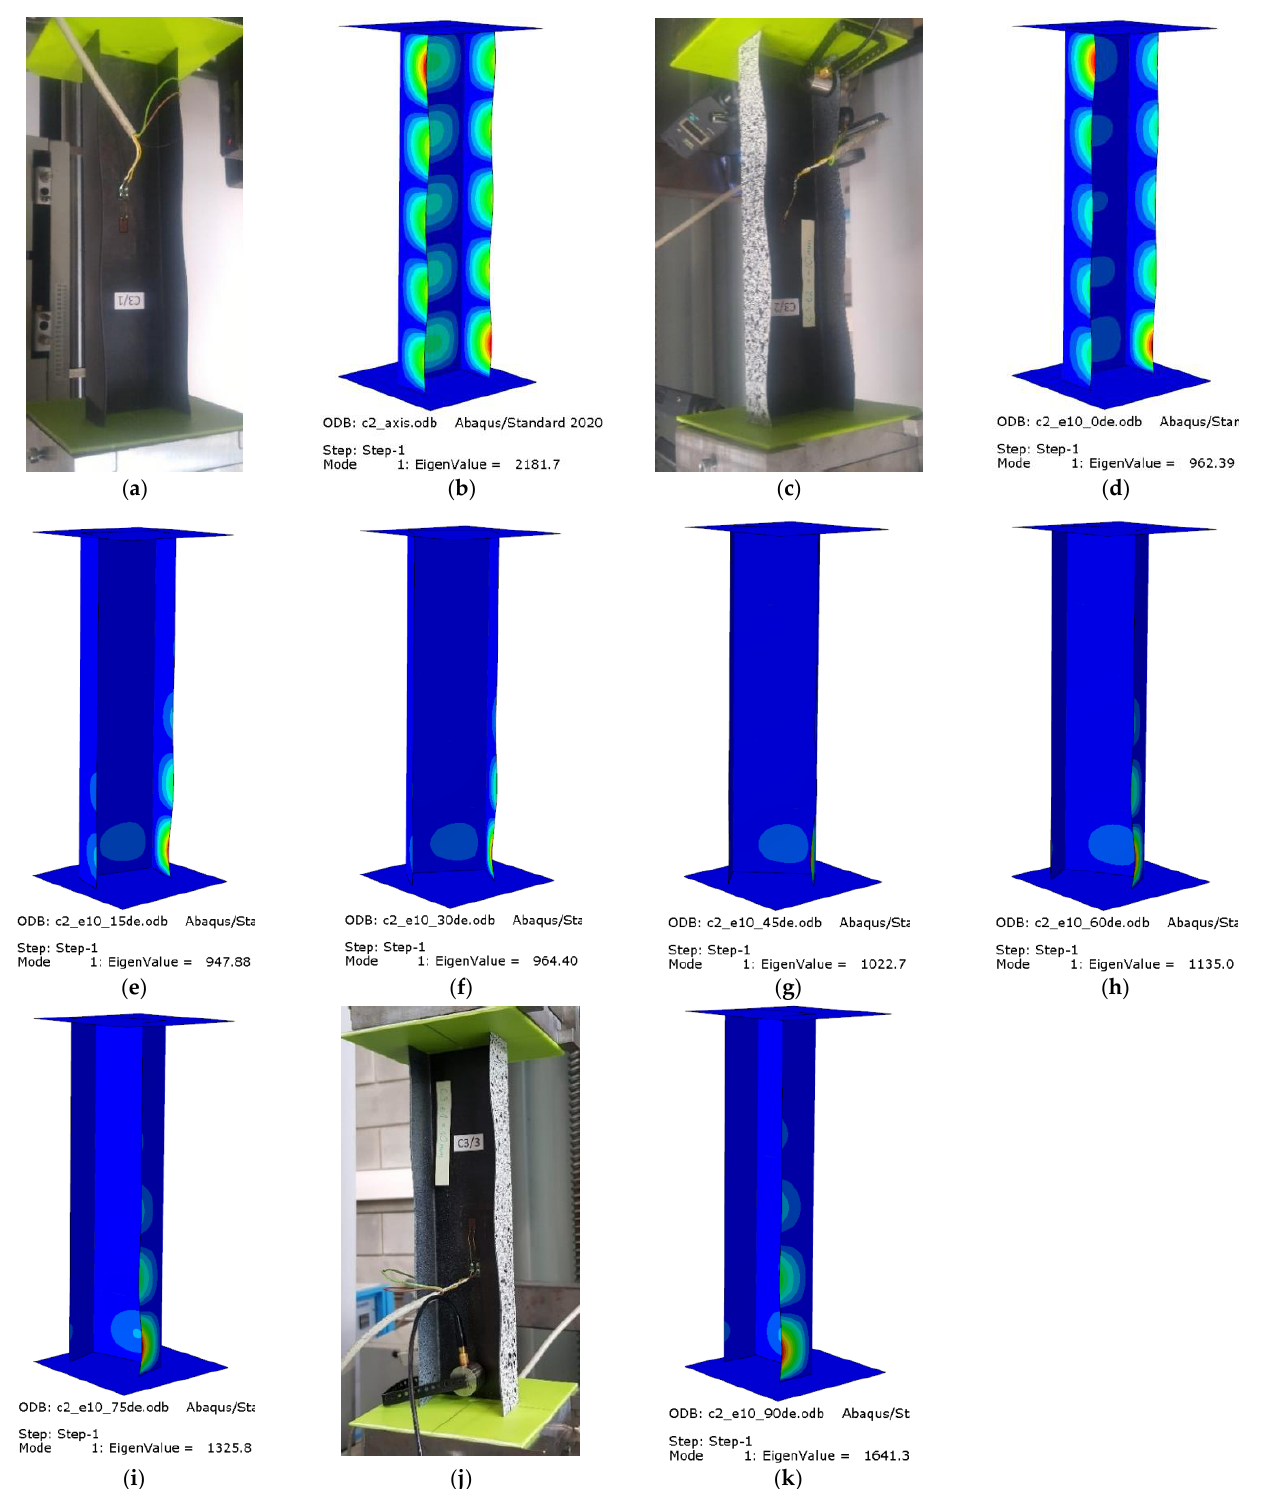
Figure 9. Buckling modes for C2 [90/ − 45/45/0] s : ( a ) axis EXP, ( b ) axis FEM, ( c ) e10_0° EXP, ( d ) e10_0° FEM, ( e ) e10_15° FEM, ( f ) e10_30° FEM, ( g ) e10_45° FEM, ( h ) e10_60° FEM, ( i ) e10_75° FEM, ( j ) e10_90° EXP, ( k ) e10_90° FEM. For the axially compressed column C1 (Figure 8a,b), local buckling of the web and walls occurs, having the form of two longitudinal half-waves symmetric to the longitudinal symmetry plane of the column. There is no change in the buckling mode of the C1 column when the eccentricity value of e10mm_0° is applied; however, one can observe increased loading of the column’s walls. This results from the fact that the point of com- pressive force application was moved, which led to unloading of the web of the column (Figure 8c,d). The eccentricity value of 15° < e = 10 mm < 75° causes a total change in the buckling mode, from two to three half-waves (Figure 8e – h). For the extreme C1 eccen- tricity case of e10mm_90°, local buckling returns to the initial mode, i.e., two half-waves. The axial compression of C2 (Figure 9a,b) is characterized by local buckling of the web and walls, with the buckling having the form of five half-waves symmetric to the symmetry plane of the column. For the eccentricity applied from the web of the C2 col- umn, i.e., e10mm_0° (Figure 9c,d), the number of half-waves on the column walls and web remains the same, but — as in the case of C1 — unloading of the web and increased loading of the walls occurs at the same time. For the eccentricity value of 15° < e = 10 mm < 90° there is a change in the buckling mode; the half-waves on the unloaded wall and the web disappear, while the half-waves in proximity of the bottom end of the column become more visible (Figure 9e – k). The experimental and numerical buckling modes showed a qualitative agreement.